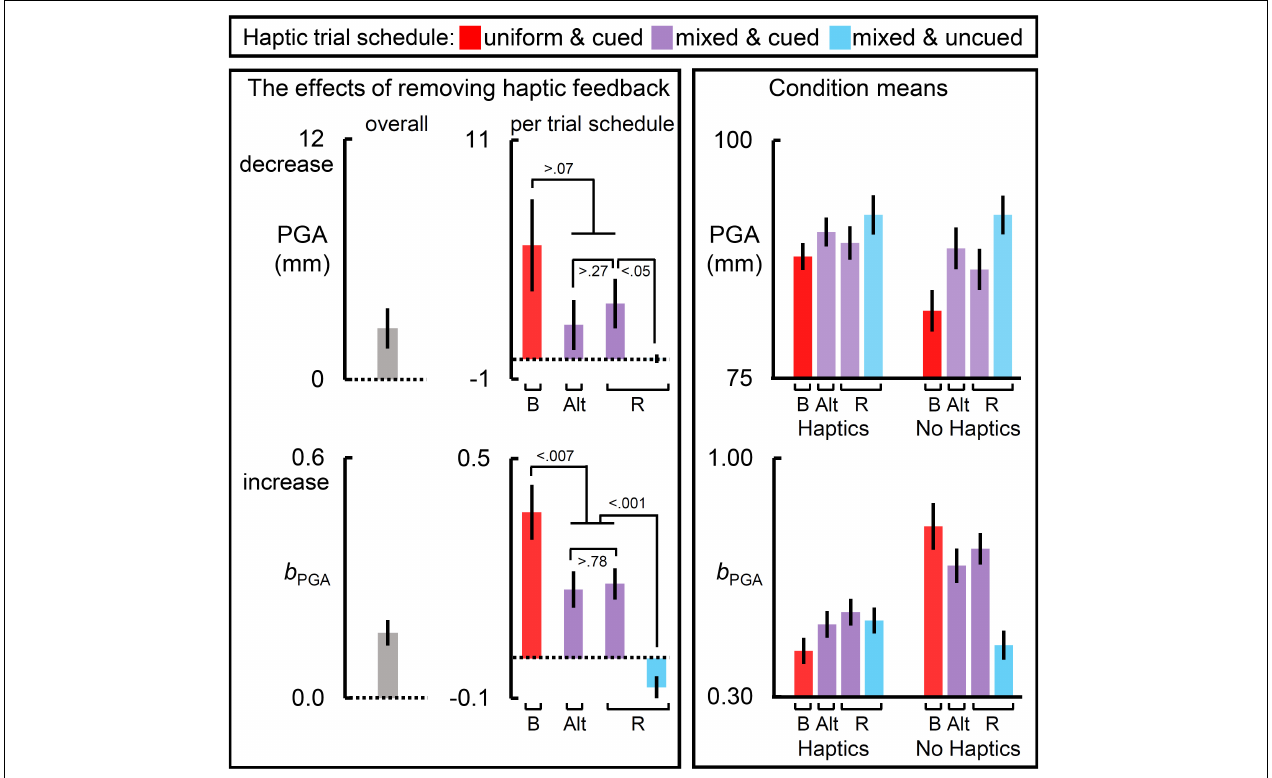
FIGURE 3 | The effects of removing haptic feedback on the in-flight grip component measures. The leftmost and middle columns of panels reflect the effects of removing haptic feedback on peak grip aperture (PGA) and the slope relating target size to PGA ( b PGA ). Removing haptic feedback reduced PGA and increased b PGA . Most notably, the schedule of haptic feedback modulated these effects (middle column of panels). On each measure, the blocked schedule yielded the largest effect, the cued mixed schedules yielded an intermediate one, and the randomly interleaved uncued schedule yielded the weakest effect. The raw condition means for each measure are depicted in the rightmost panels. Bar label “B” refers to the blocked trial order; “Alt.” alternating block of trials; and “R” randomized ones. Dotted lines reflect a null effect of removing haptic feedback. All error bars reflect SEMs, and the dotted lines reflect the null hypothesis for tests against